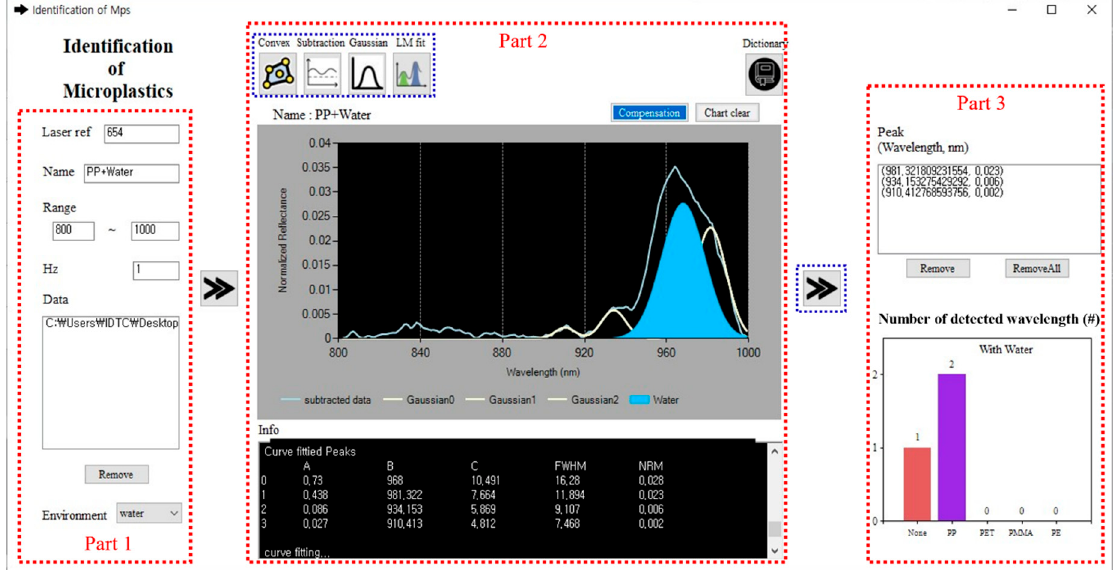
Figure 4. Image of the in-house program for microplastic classification. For instance, the water is selected in the ’Environ- ment’ in Part 1, and the classified peak wavelengths in Part 2 represent one non-identified peak (None) and two identified peaks (PP) in Part 3.